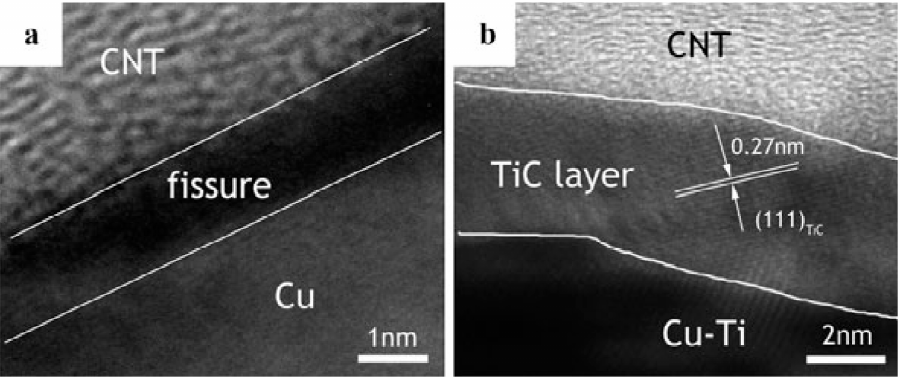
Figure 24. TEM images of CNT/Cu interfaces: ( a ) The formation of a pronounced crevice due to the lack of wettability and ( b ) the precipitation of in situ TiC layer as a result of Ti addition to pure Cu matrix [149]. (Reproduced with permission from [149], Springer, 2013.)